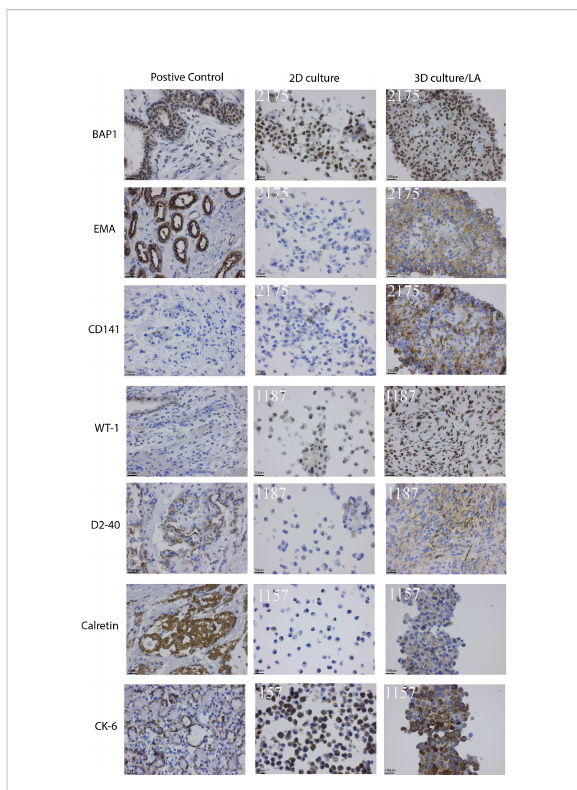
FIGURE 3 Clinically used mesothelioma biomarkers expression pattern for primary MPM cell lines. Primary MPM cell growth in 3D spheroids demonstrated an increase in IHC marker expression compared to 2D culture. Patient tissue samples were used as